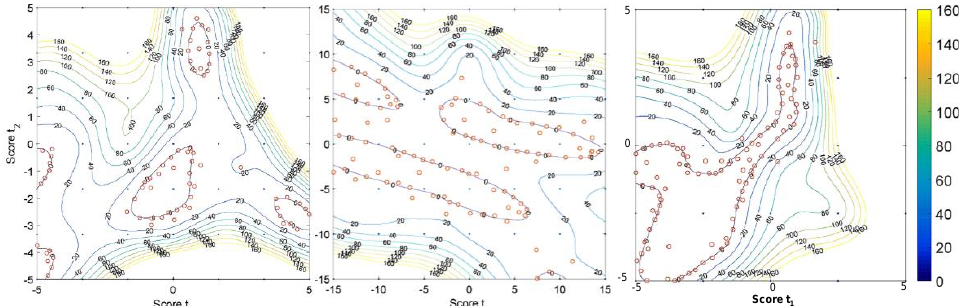
Figure 9. Design space characterization of a milling + tableting process. Reproduced with permission from Bano et al., Computers and Chemical Engineering; published by Elsevier, 2018 [60].